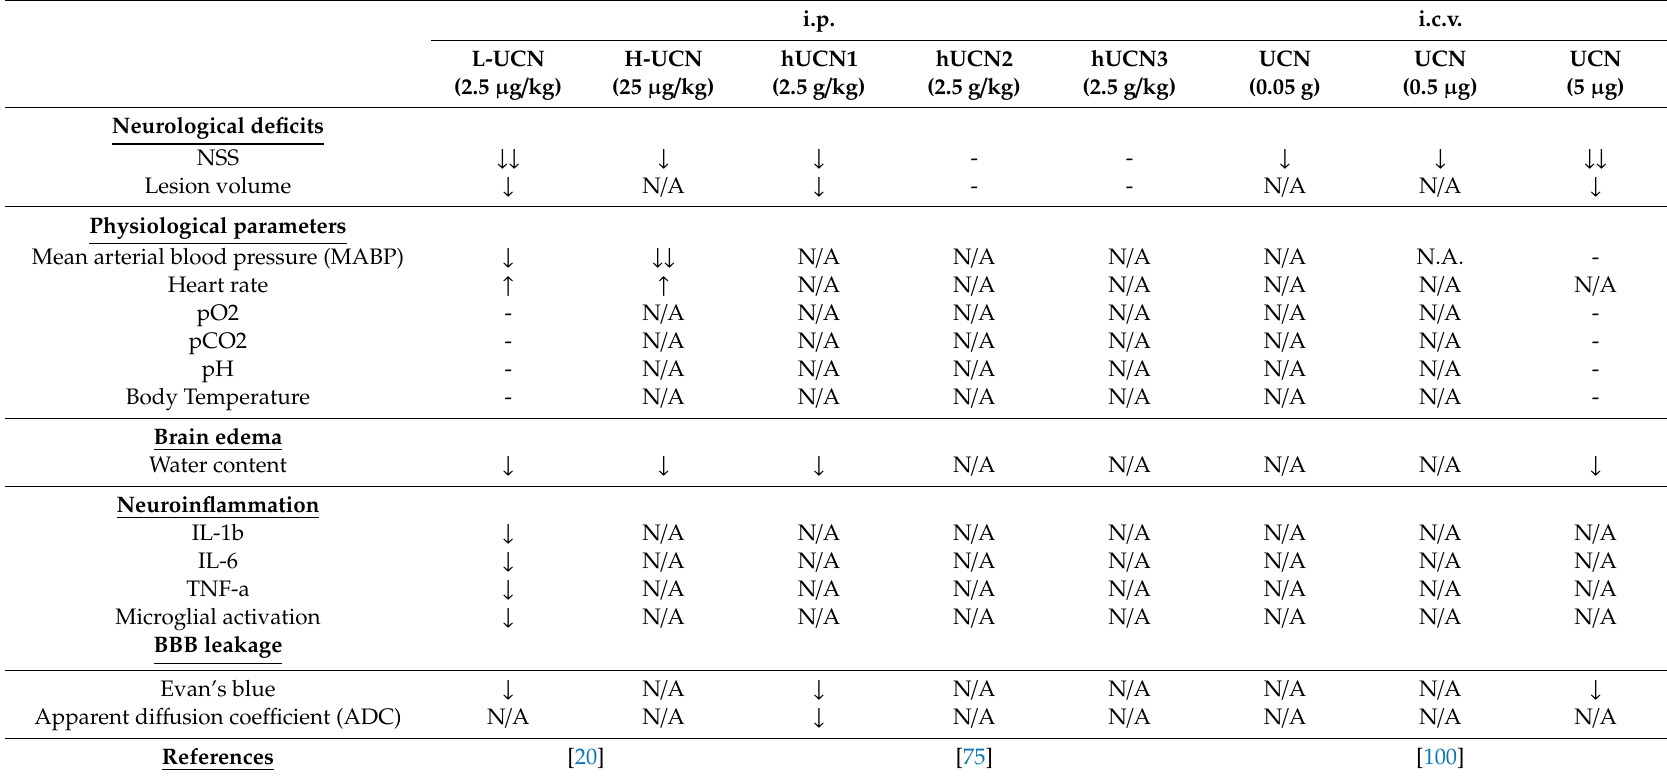
Table 3. Results of urocortin in intracerebral